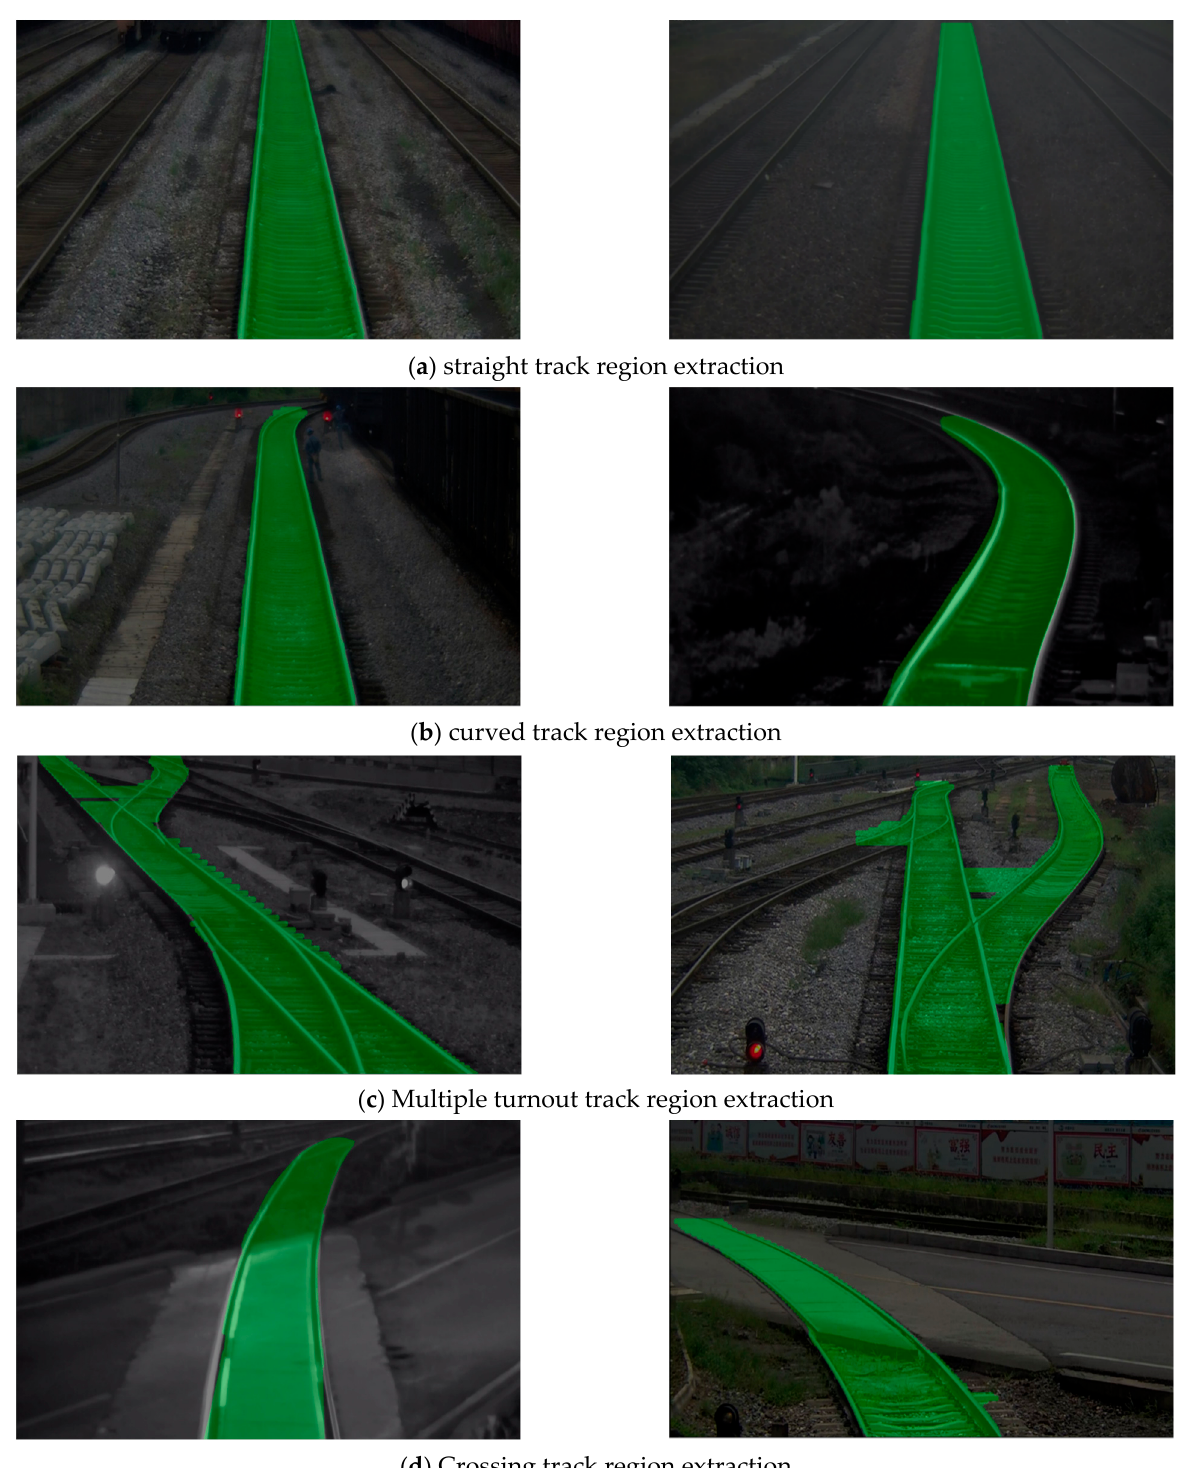
Figure 14. Track region extraction based on track line matching under different lines and light conditions (the track region is colored in green).